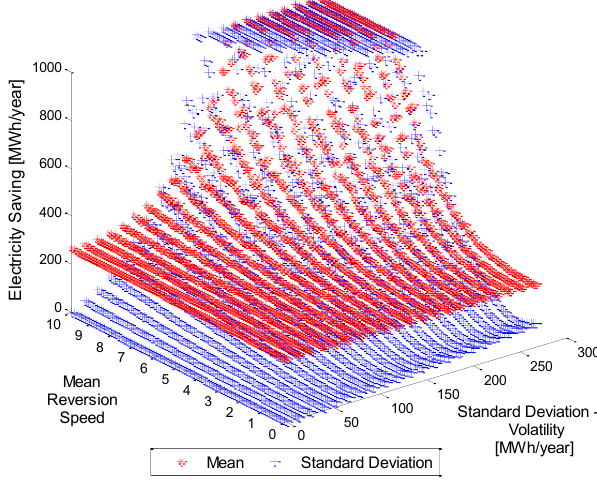
Fig. 4. Probability density function of the annual electricity saving Fig. 6. Mean and standard deviation of electricity saving by variation of σ and η